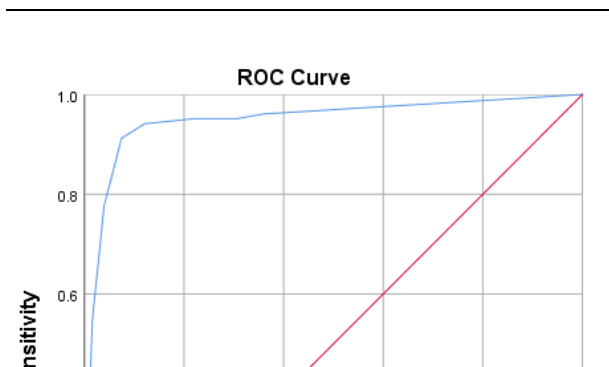
Figure 4. Path diagrams for the HAMD-4 and HAMD-6.